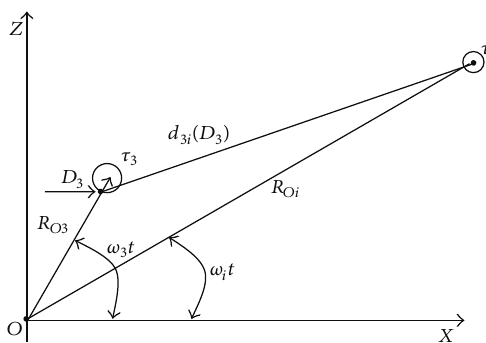
Figure 8: The geometric sketch of circulation of the outer planet 𝜏 𝑖 (Mars or Jupiter, Saturn, Uranus, Neptune, and Pluto) and Earth 𝜏 3 around the mass center 𝑂 of the